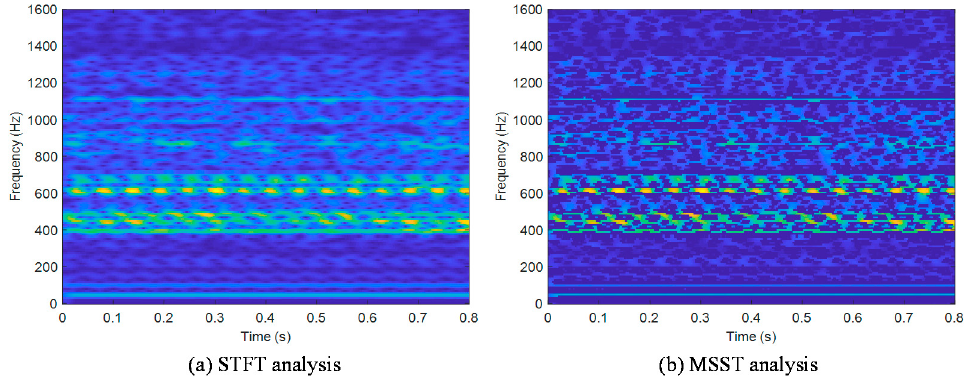
Figure 5. Feature extraction results of frequency bands with two methods.